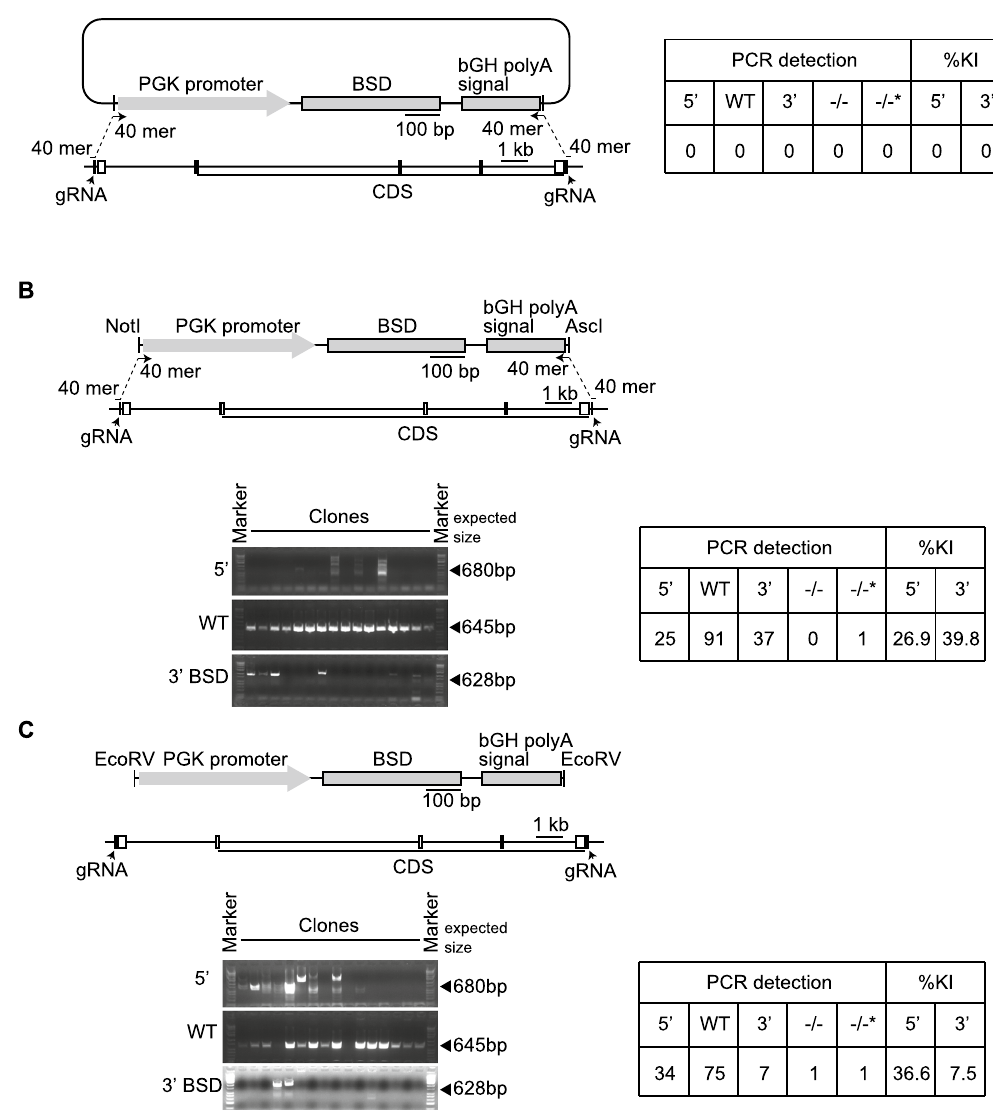
Figure 3. The blunt-end of the cassette with selection marker and single-strand oligodeoxynucleotides (ssODNs) were critical for increasing the efficiency to knock the cassette into genome. ( A , B ) The schemas of knockout of the target gene by pX330 plasmids, ssODNs, and un-cut plasmid with selection marker ( A ) or sticky ends of DNA coding selection marker cut by NotI and AscI ( B ). ( C ) The schema of knockout of the target gene by pX330 plasmids and the DNA with selection marker smoothly cut by EcoRV without ssODNs. Agarose gel images showing the genotyping results. The tables indicate the genotyping results of 93 clones. 5 ′ , 5 ′ site between the genomic region and the cassette; 3 ′ , 3 ′ site between the genomic region and the cassette; WT, wild- type allele; −/−, homozygously knockout clones: −/−*, homozygously knockout clones without the detection of 5 ′ or 3 ′ sites ligation between the genomic region and the cassette; %KI, percentage of knock-in in 93